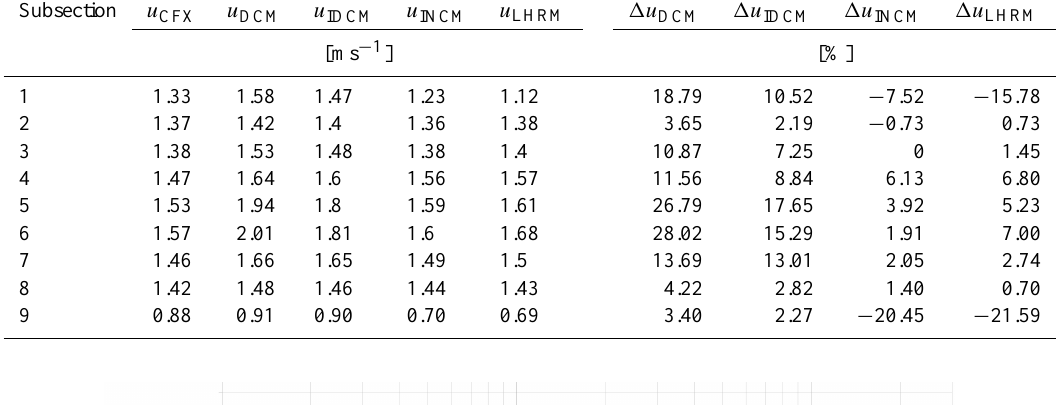
Table 8. Simulated mean velocities in each segment section using 1-D hydraulic models with DCM, IDCM, INCM, LHRM and CFX, and the corresponding differences.